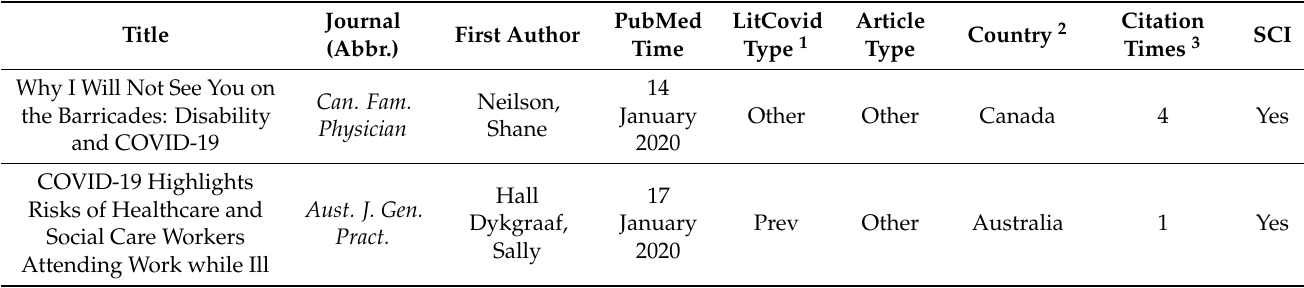
Table 5. Top fastest-published COVID-19-related articles in family medicine journals indexed PubMed in